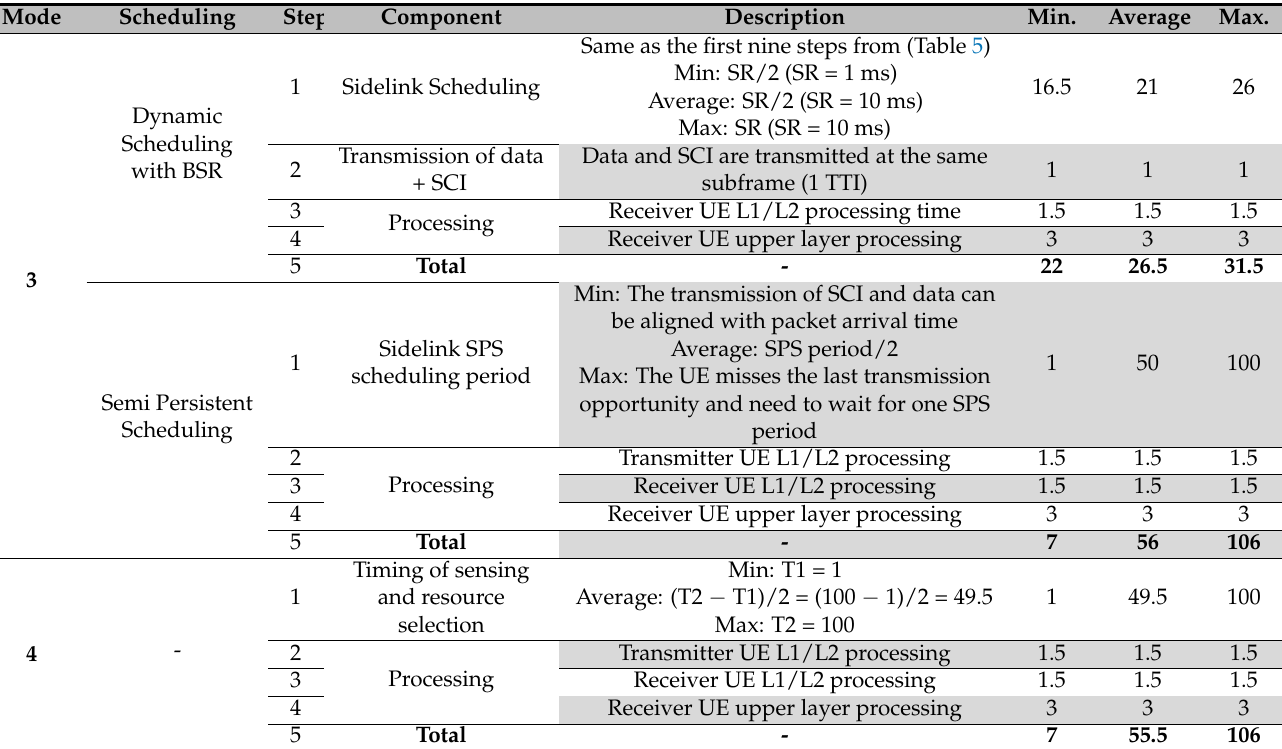
Table 7. Sidelink delay in LTE-A